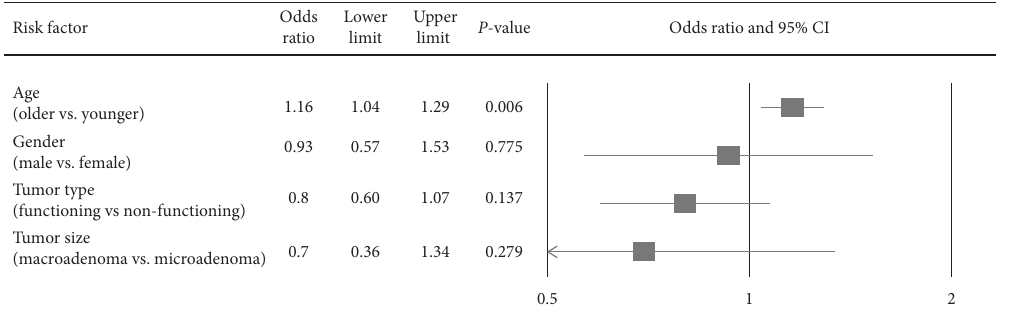
Figure 4: Meta-analysis for the associations between delayed hyponatremia and age, gender, tumour type, and tumour